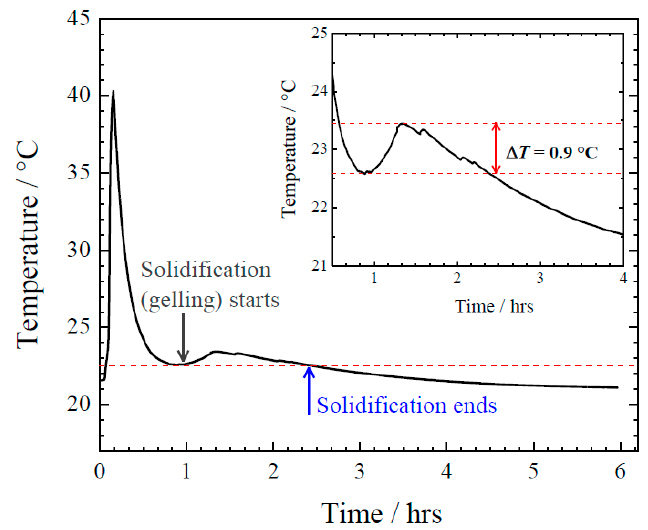
Figure 6. Temperature versus time curve from 21.5 °C to 40 °C collected while heating a 15 mL sample of R-CNO by hot air and then letting the sample cool at room temperature. The cooling started at time t = 0.13 hrs. The inset shows a close-up of the solidification region, with a measured supercooling of 0.9 °C.